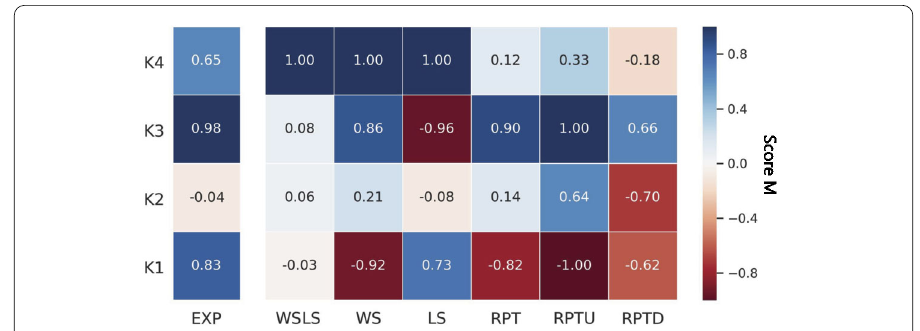
Figure 5 Patterns of behavior for each group of users. For each group of users we show the score M kb (see text) for each pattern of behavior b (from left to right): (EXP) Following the expert’s advice; (WSLS) – Win-stay loose-shift; (WS) Win stay; (LS) Loose shift, (RPT) Repeat previous guess; (RPTU) Repeat previous decision if it was ↑ ; RPTD Repeat previous decision if it was ↓ . A score of 1 means the group completely follows a basic pattern, and a score of –1 means it does the exact opposite of the basic pattern. Every group displays a preferential (if not systematic) pattern of behavior: K4 behaves according to the WS-LS strategy, K3 repeats the previous guess, K2 always guesses ↑ and K1 changes the previous guess. Additionally, the expert’s advice is either followed or ignored, but none of the groups systematically makes the opposite decision. Note that because the expert is consulted in less than 30% of the rounds, we split the data set into expert consulted and not consulted. From the former we get the score for the EXP strategy, while from the latter we obtain the scores for the other behavioral patterns